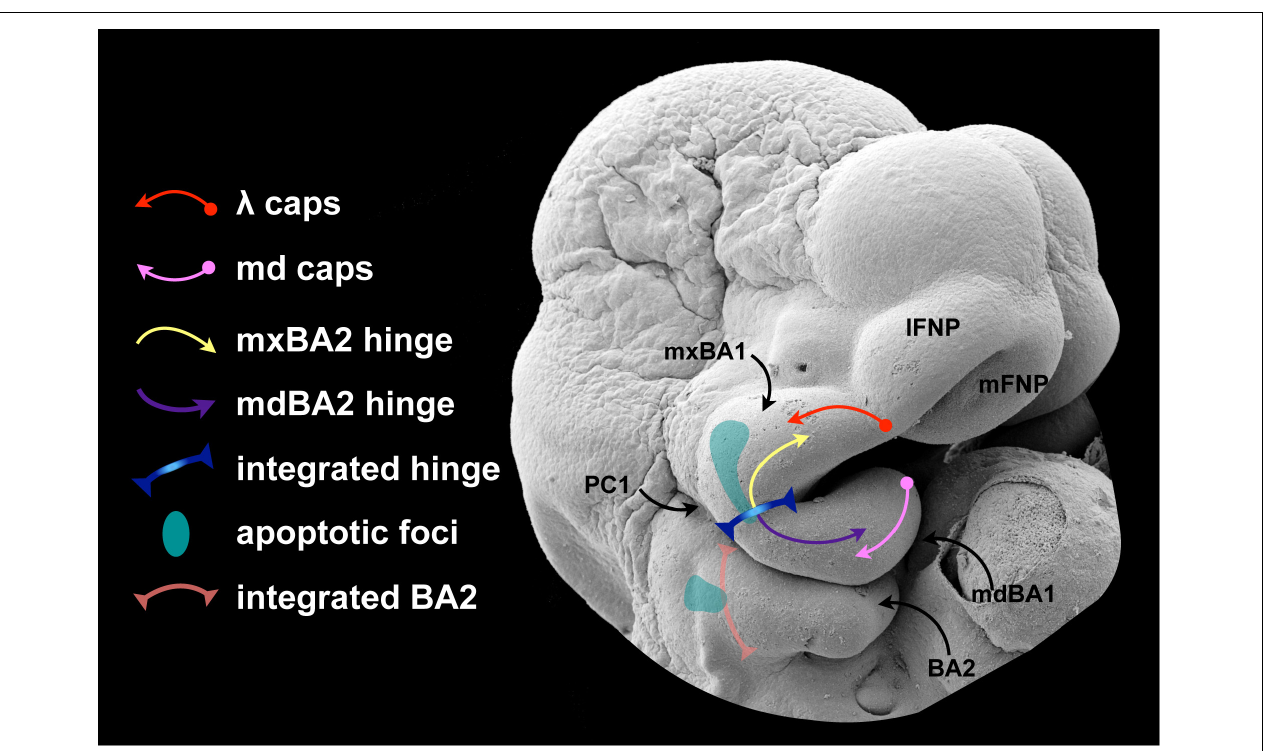
FIGURE 7 | A proposed role for apoptosis in hinge and caps